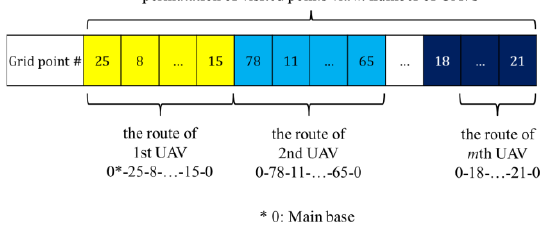
Figure 3. Permutation-based